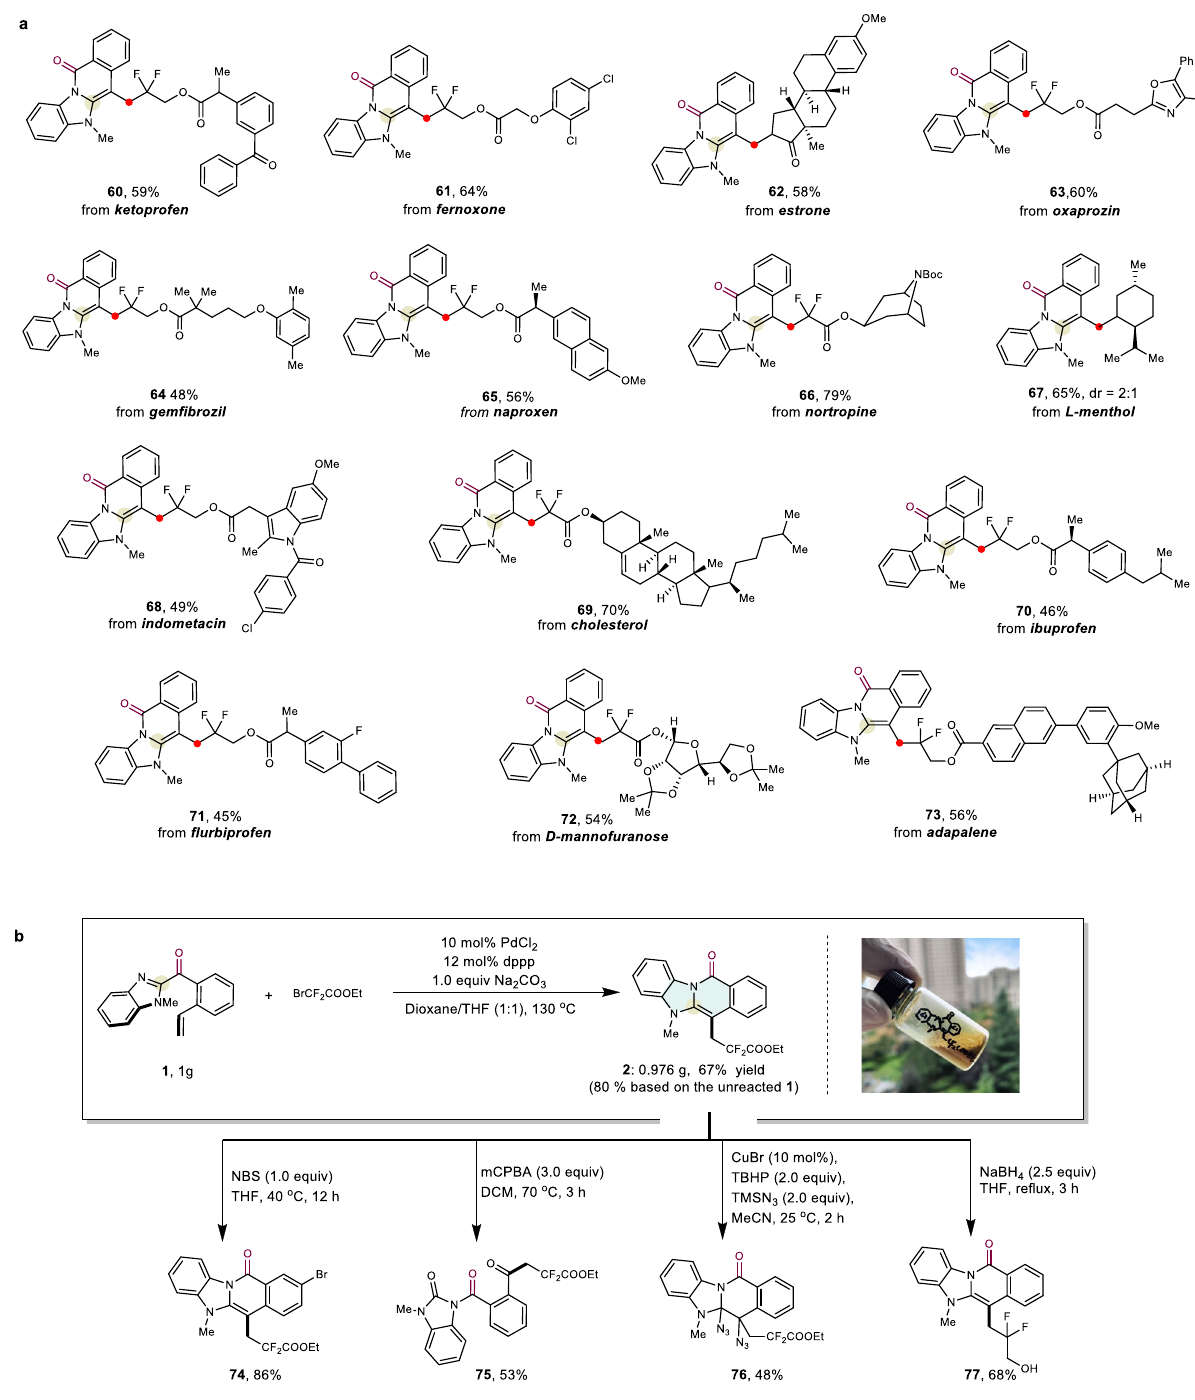
Fig. 5 Synthetic applications. a Using the tranfer-annulation strategy in the late-stage modi fi cations of complex frameworks based on natural products and drug molecules. b Gram-scale synthesis and various useful transformations of 2 . The CCDC number of 74 is